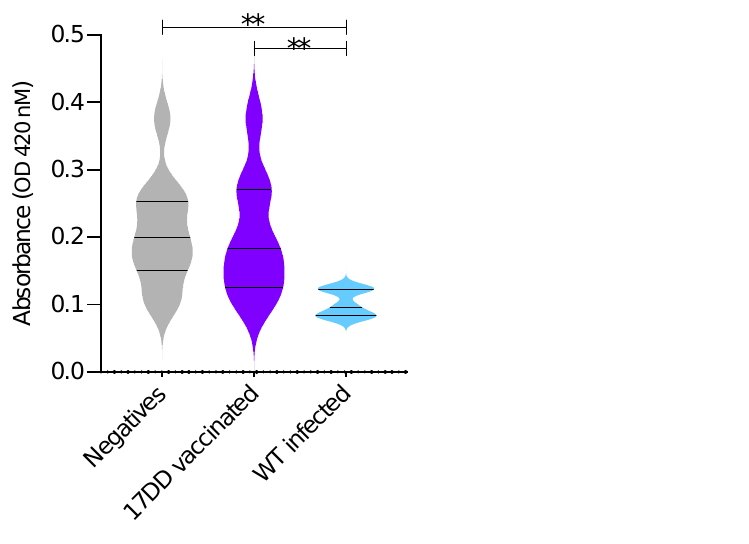
Figure 3. Recognition pattern of peptide 007dd from sera collected from different groups of individuals. ELISA was employed to verify if sera from 17DD-YFV individuals were more strongly recognized by 007dd peptide than WT-YFV infected individuals. Statistical differences among groups were assessed using Kruskal–Wallis with Dunn’s multiple comparisons test (GraphPad Prism). Differences between groups with p < 0.01 are represented with two asterisks (**) connected by dashed bars.